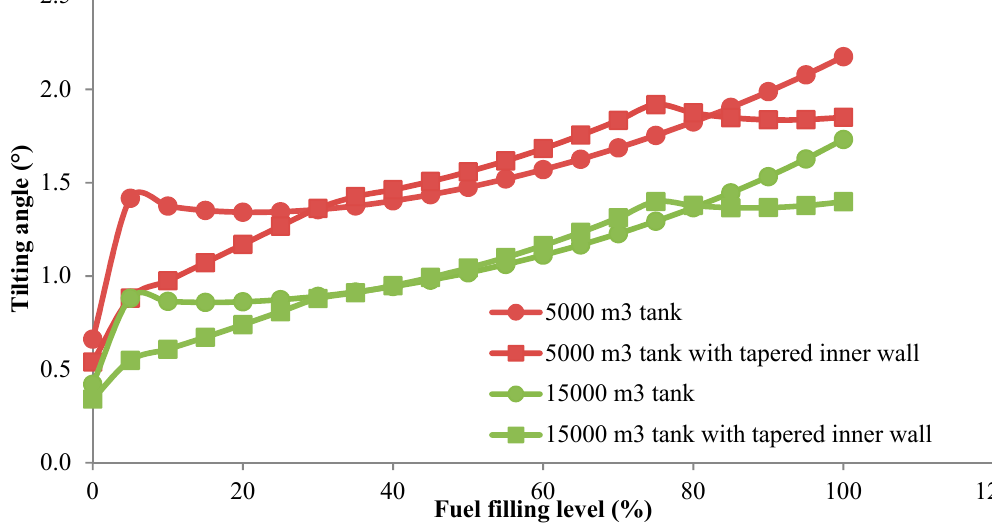
Figure 24. E ff ect of tapered inner wall configuration on tilting angle of tanks.